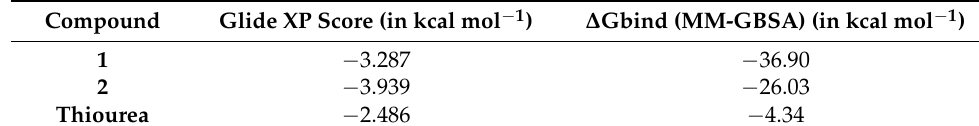
Table 8. Molecular docking score and binding free energy for compounds 1 and 2 .